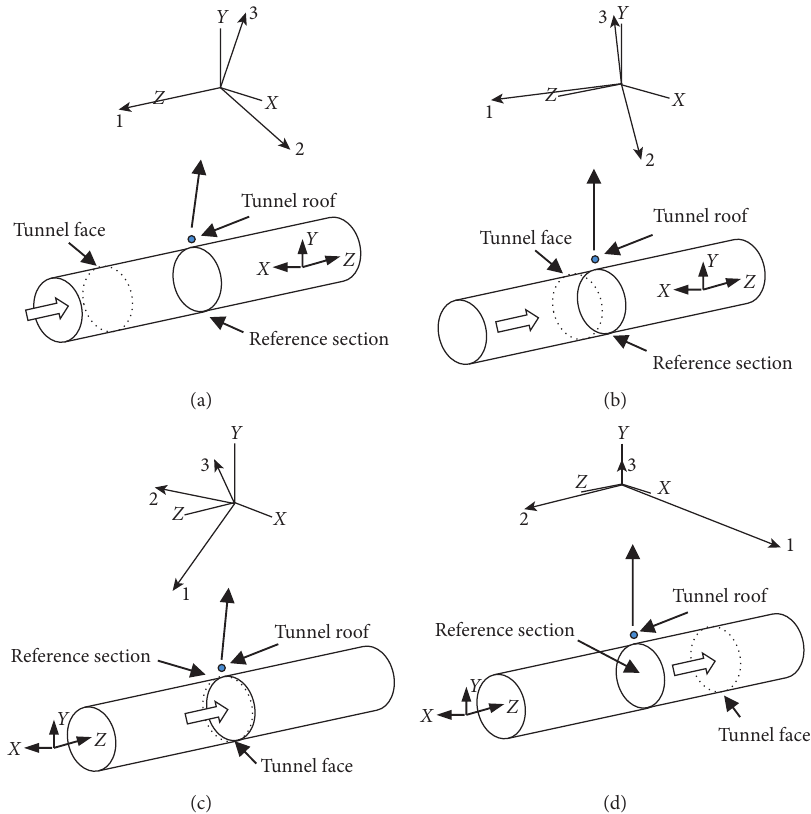
Figure 4: Principal stress orientation vectors of the tunnel roof at different advancing stages.(a) Tunnel face far from the reference section. (b) Tunnel face before the reference section. (c) Tunnel face on the reference section. (d) Tunnel face behind the reference section.